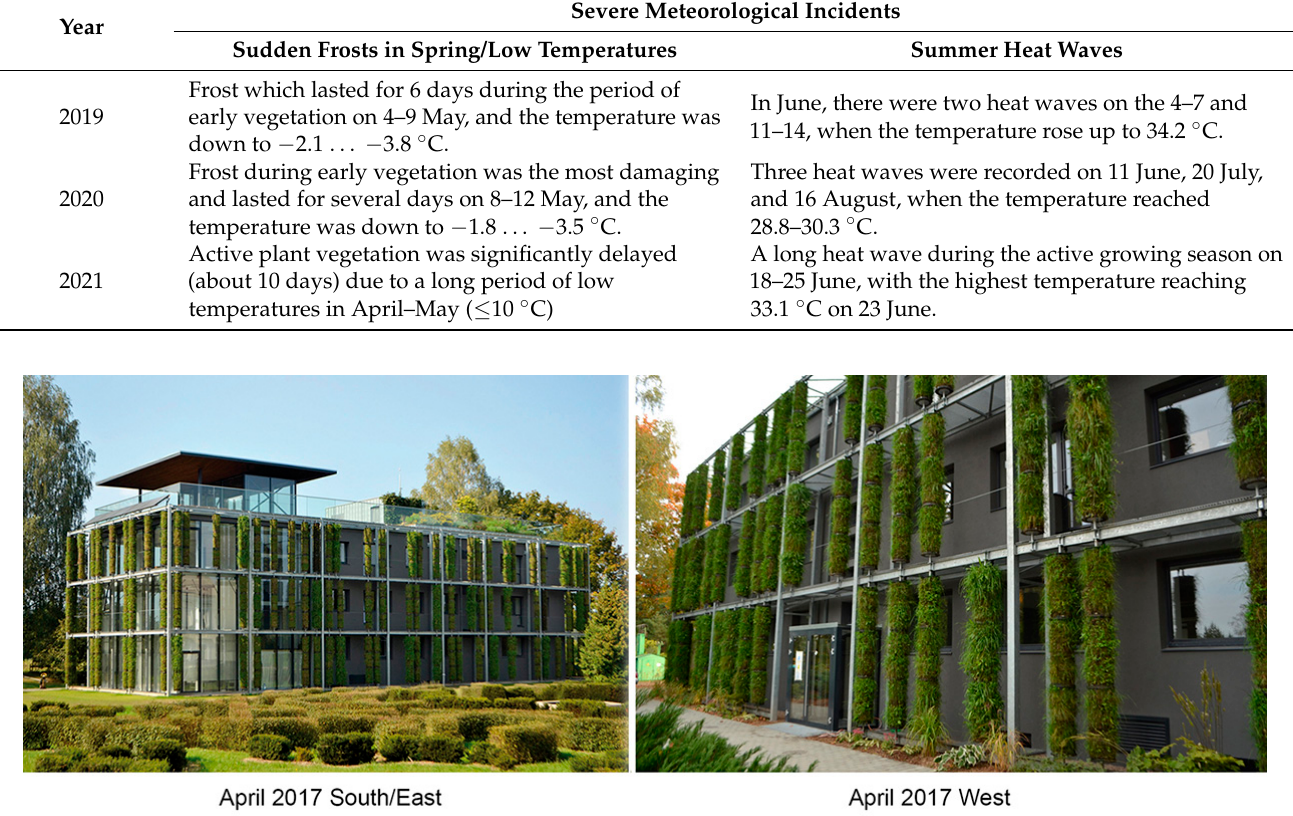
Figure 3. The green columns during the first year’s spring season on the south/east and west expositions, April 2017.